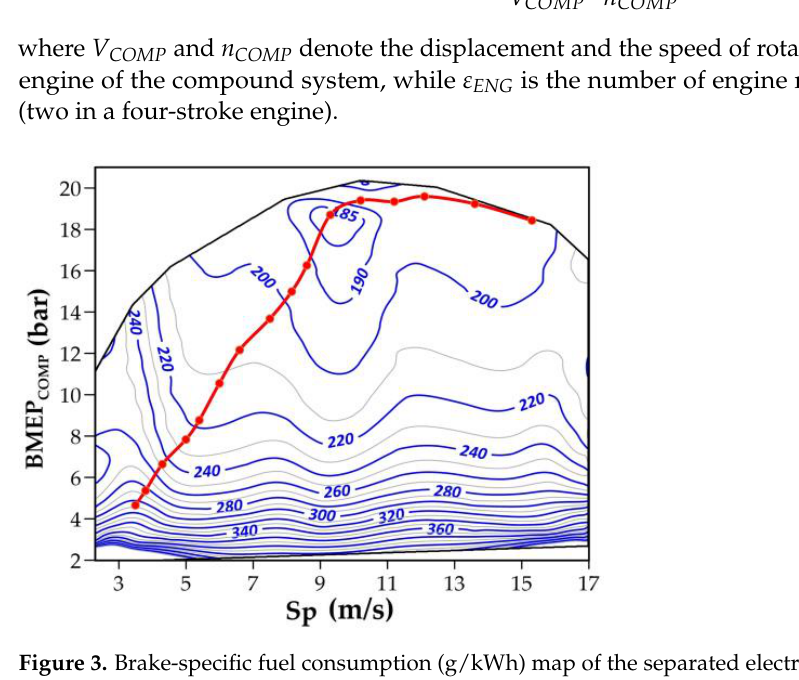
Figure 3. Brake-specific fuel consumption (g/kWh) map of the separated electric compound engine studied in [2]. The best efficiency curve is also reported.